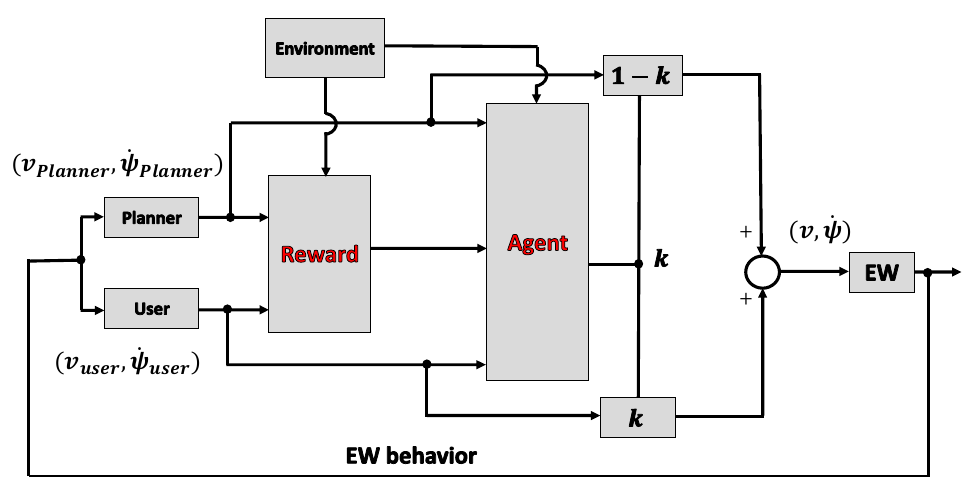
Figure 7. Structure of shared control using reinforcement learning.